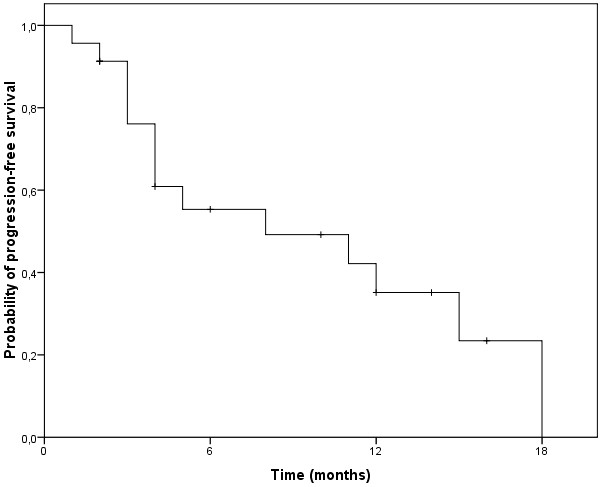
Kaplan-Meier-Estimation of progression-free survival.